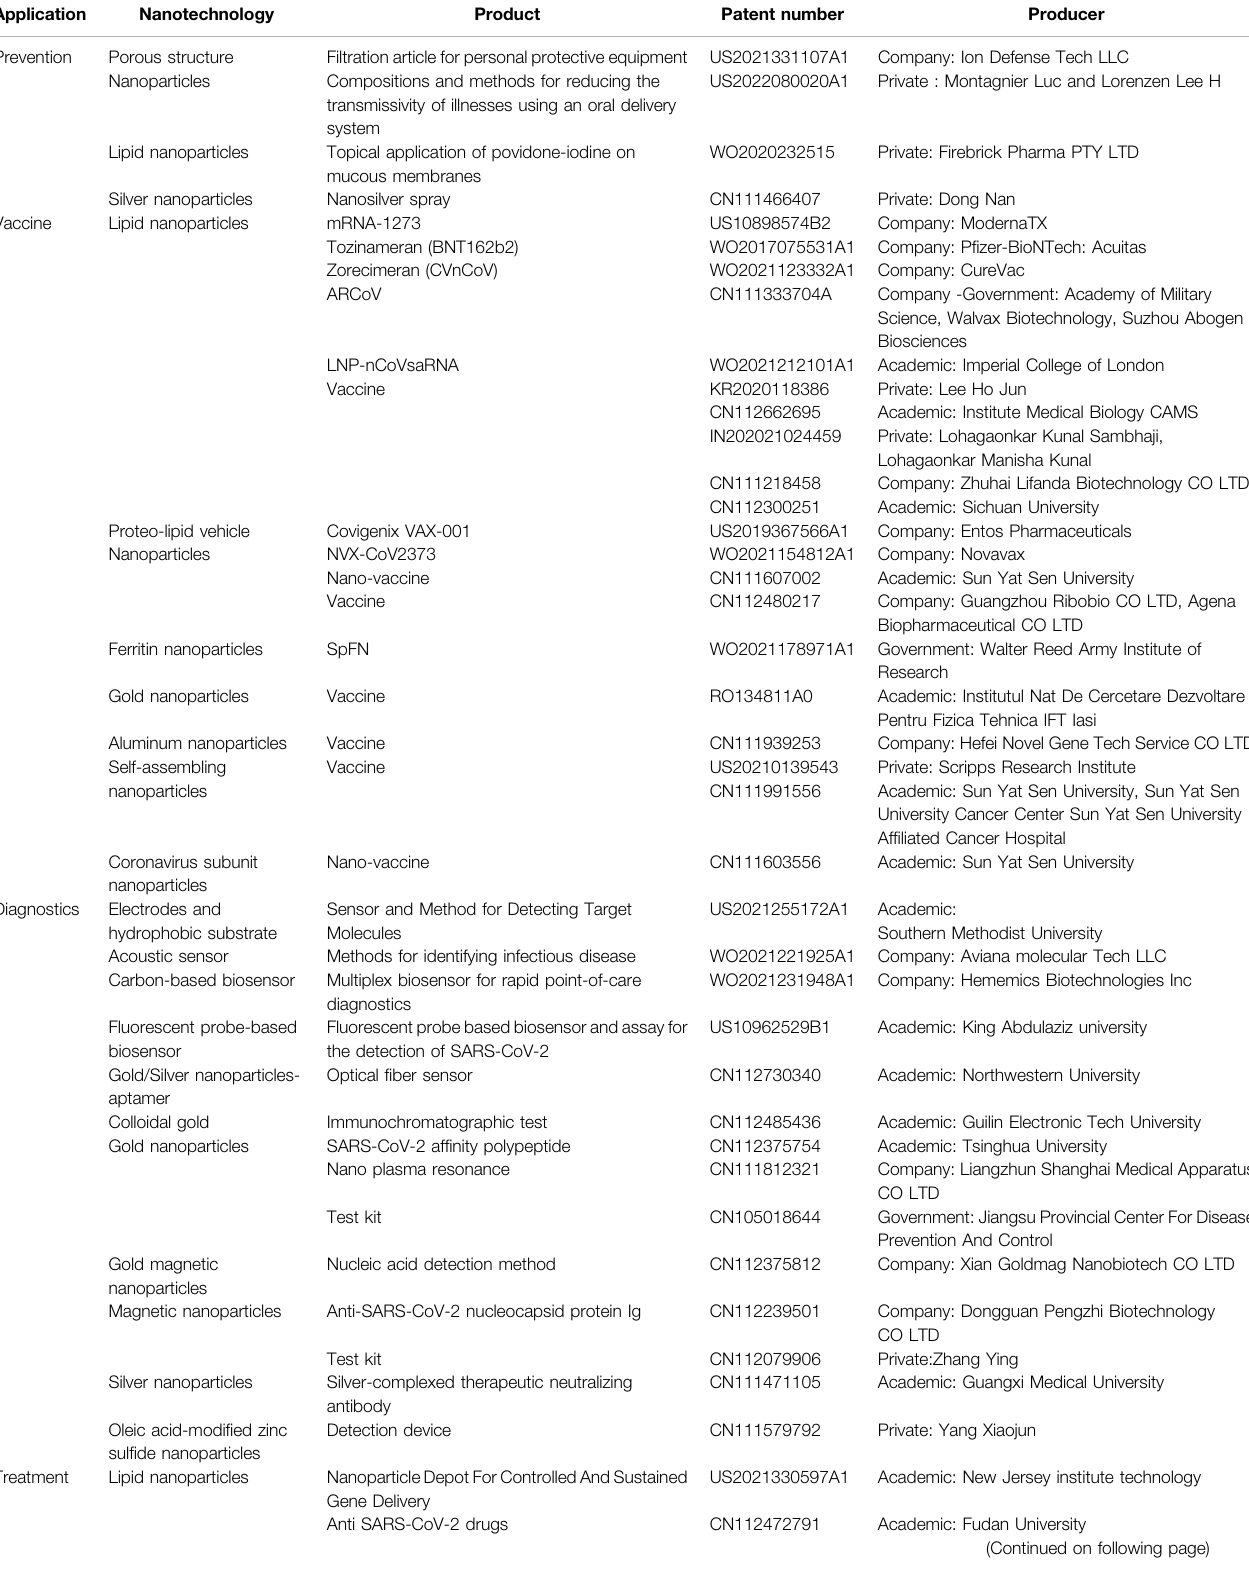
TABLE 1 | Patents related to the applications of nanobiotechnologies for COVID-19 prevention, vaccines, diagnosis, and treatments. Data from Tavares et al. (2022) and from a query on VaxPal and ESPACENET websites carried out on April